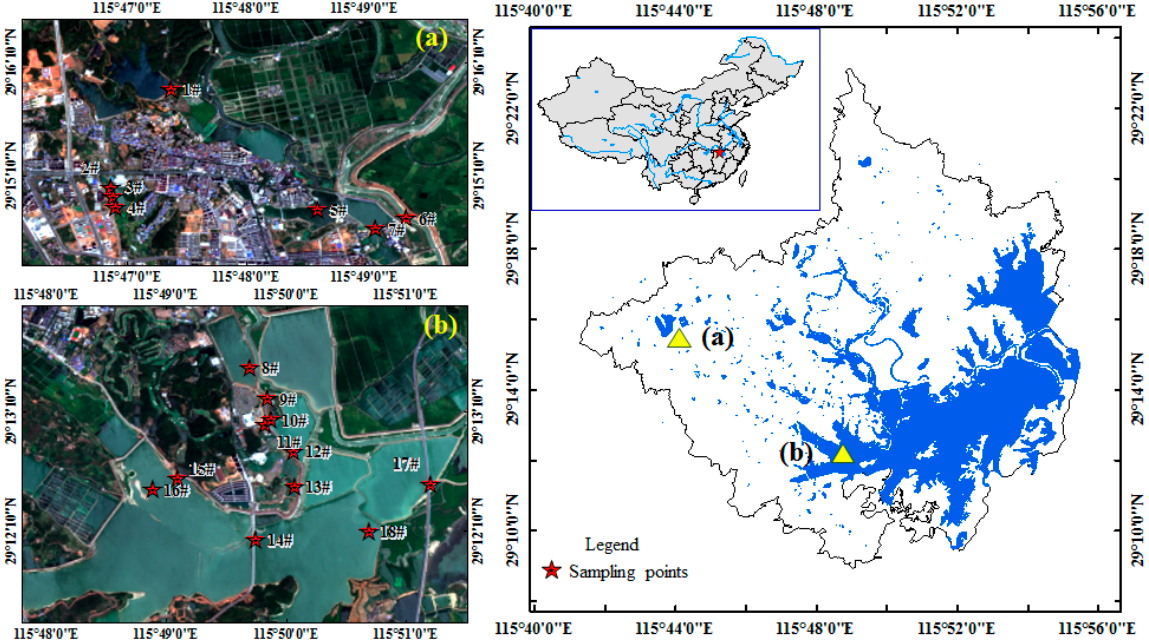
Figure 1. Location of the study area and the distribution of ( a ) the first eight sampling sites located in reservoirs, rivers, independent lakes and ( b ) the other ten samplings sites located in the whole Nanhu lake.